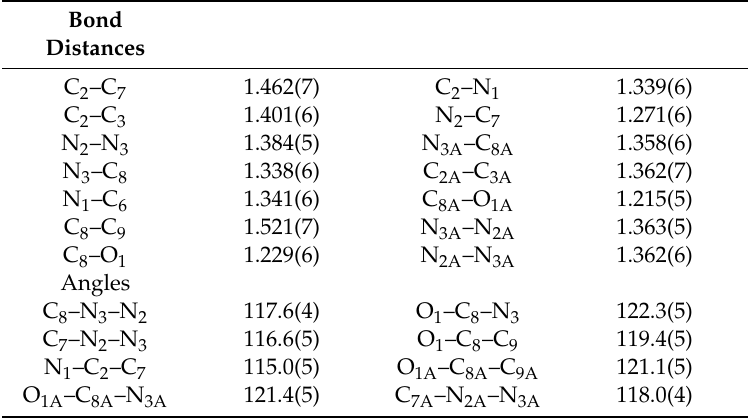
Table 5. Selected bond lengths (Å) and angles ( ◦ ) for ligand